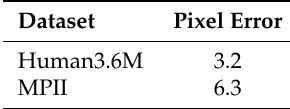
Table 3. Performance of 2D human pose estimation. The numbers denote mean Euclidean distances in